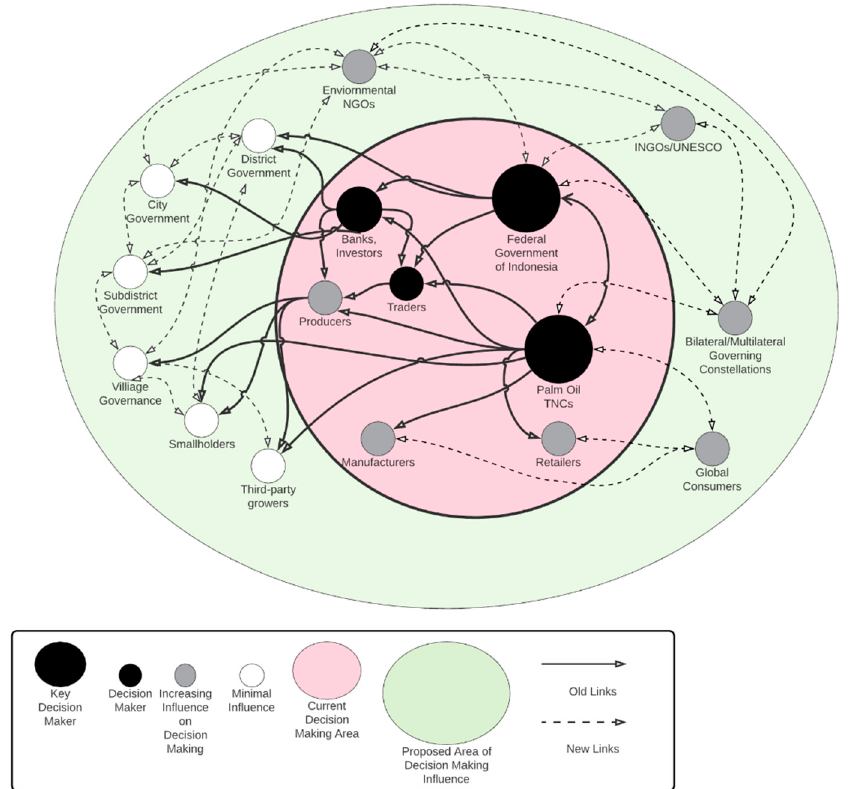
Figure 5. Non-hierarchical Polycentric Governance. Adapted from “Evolving polycentric govern- ance of the Great Barrier Reef,” 2017, T. Morrison. Many conventional systems of environmental governance are unable to cope with novel forms of social and environmental change. Polycentric governance systems occasionally struggle with adapting to the affect, speed, and depth of such multi-transitive changes. Our synthesis of a non-hierarchical polycentric system ensures inclusiv- ity, transparency, accountability and legitimacy across all actors in the supply chain, implanting a series of micro-level transformational “nodes” for boosting response diversity in and across global actor networks.